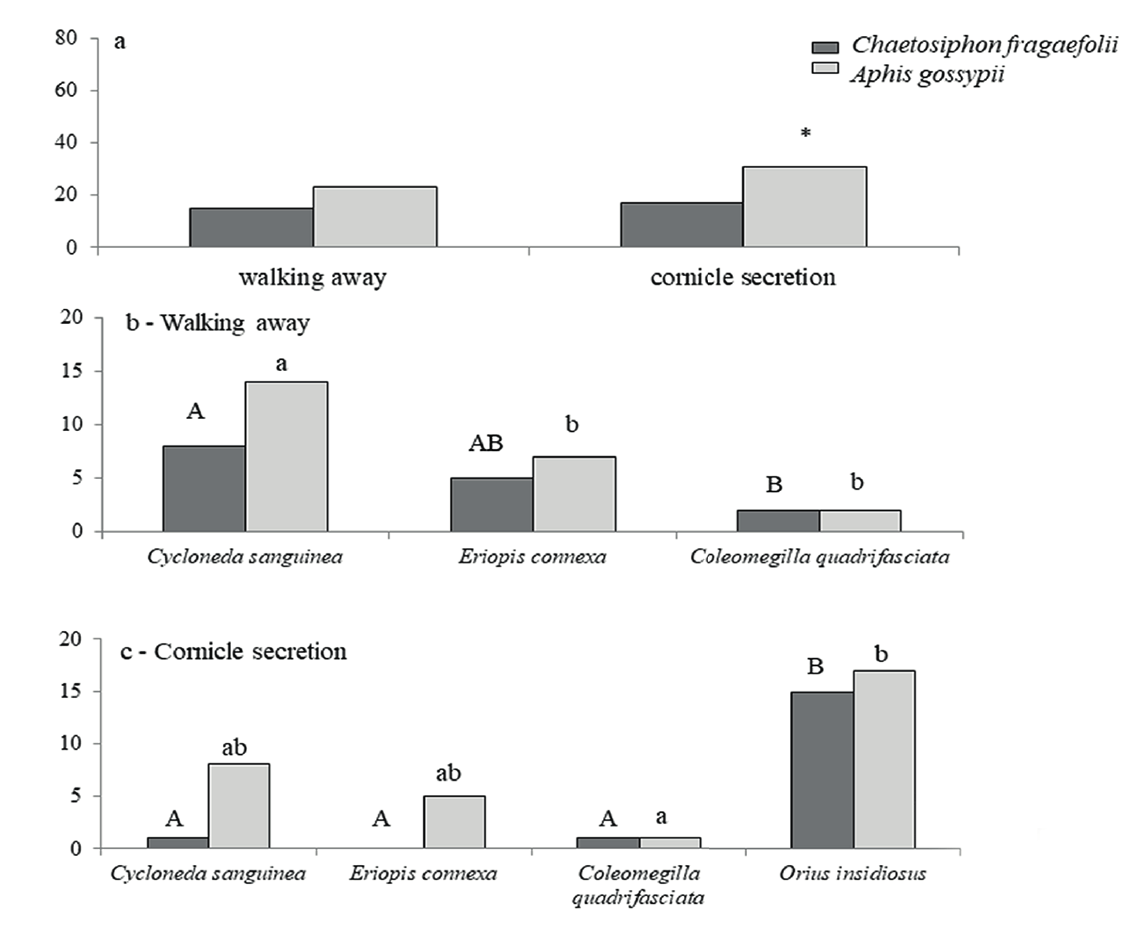
Figure 1 - Results of antipredator behavior assay showing the frequency (number of replicates) of a ) total walking away and cornicle secretion behaviors, b ) walking away and c ) cornicle secretion behaviors of aphid species in the presence of diff erent predator species. Asterisk indicates signifi cant diff erences between aphid species for each behavior; uppercase letters and lowercase letters show signifi cant diff erences for C. fragaefolii and A. gossypii , respectively, in the presence of diff erent predator species ( P